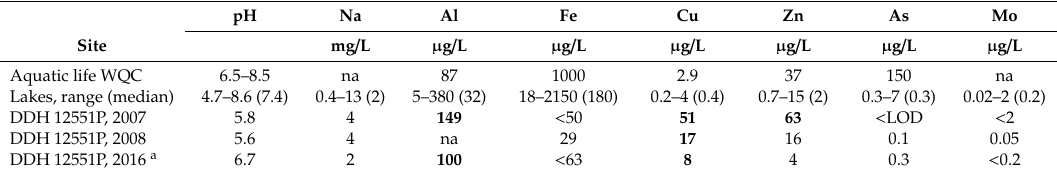
Table 4. Pond chemistry. Pond samples are labeled using the drill-hole closest to the pond and the letter “P” to distinguish the pond sample from samples at the drill-stem. Bold—concentration exceeds WQC. WQC—water quality criteria for aquatic life [23]; for hardness-dependent metals a hardness of 25 mg / L was applied. Lake data is from [13]. LOD = limit of detection